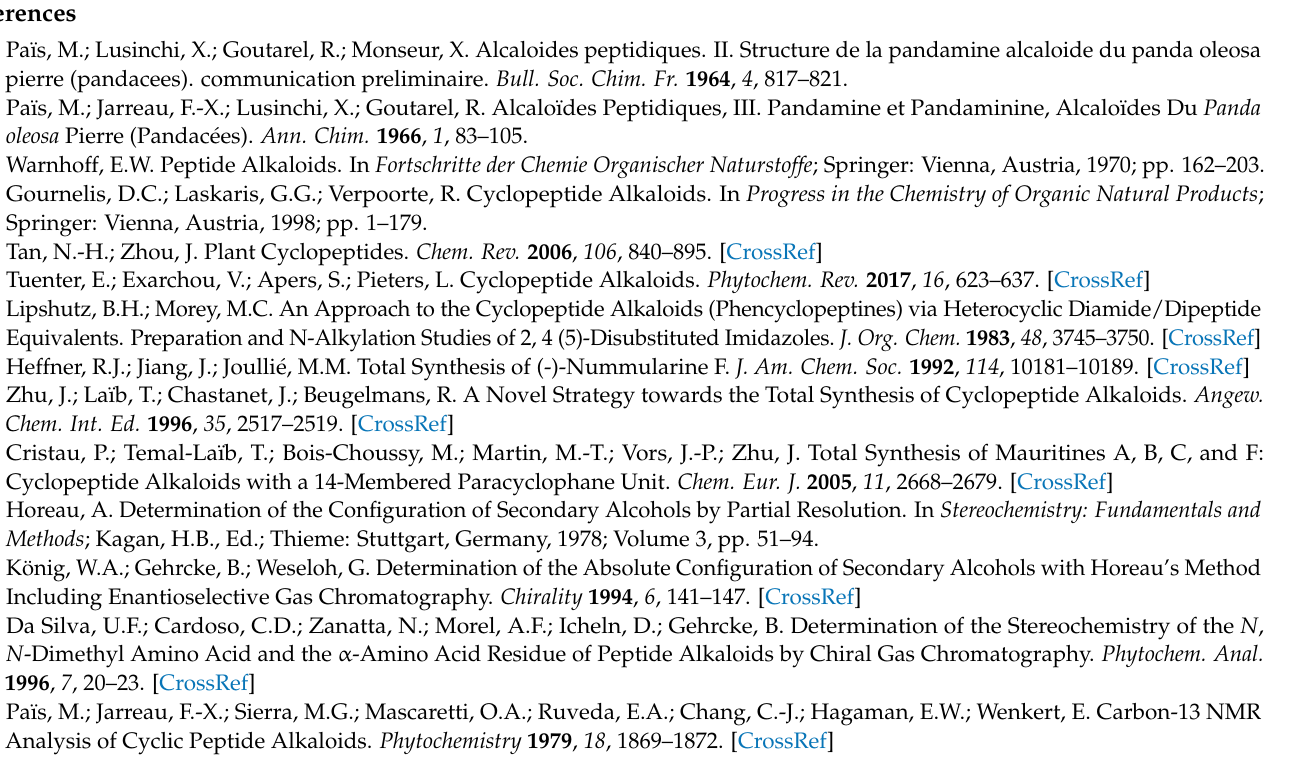
Figure S2: 1 H NMR (DMSO- d 6 , 500 MHz) spectrum of pandamine ( 1 ); Figure S3: 13 C NMR (DMSO- d 6 , 125 MHz) spectrum of pandamine ( 1 ); Figure S4: COSY (DMSO- d 6 , 500 MHz) spectrum of pan- damine ( 1 ); Figure S5: COSY-TOCSY (DMSO- d 6 , 500 MHz) spectrum of pandamine ( 1 ); Figure S6: Edited HSQC (DMSO- d 6 , 500/125 MHz) spectrum of pandamine ( 1 ); Figure S7: HSQC-TOCSY (DMSO- d 6 , 500/125 MHz) spectrum of pandamine ( 1 ); Figure S8: HMBC (DMSO- d 6 , 500/125 MHz) spectrum of pandamine ( 1 ); Figure S9: ROESY (DMSO- d 6 , 500 MHz) spectrum of pandamine ( 1 ); Figure S10: 1 H NMR (TFA- d , 500 MHz) spectrum of pandamine ( 1 ); Figure S11: 13 C NMR (TFA- d , 125 MHz) spectrum of pandamine ( 1 ); Figure S12: COSY (TFA- d , 500 MHz) spectrum of pandamine ( 1 ); Figure S13: (A) Edited HSQC (TFA-d, 500/125 MHz) spectrum of pandamine ( 1 ), (B) HMBC (TFA-d, 500/125 MHz) spectrum of pandamine ( 1 ).; Figure S14: ROESY (TFA- d , 500 MHz) spectrum of pandamine ( 1 ); Figure S15: X-ray crystallography related data, Table S1: Crystal data and structure refinement for pandamine ( 1